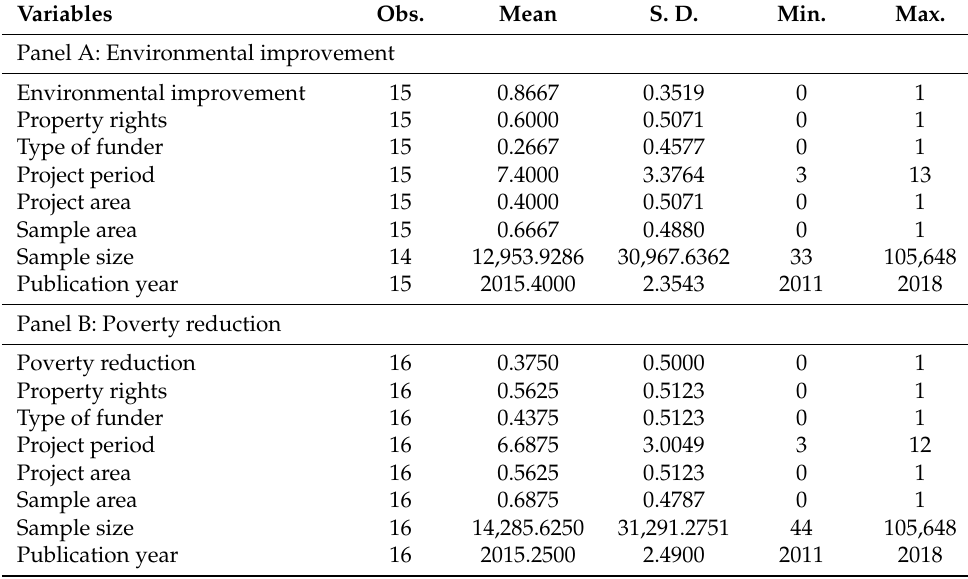
Table 3. Descriptive